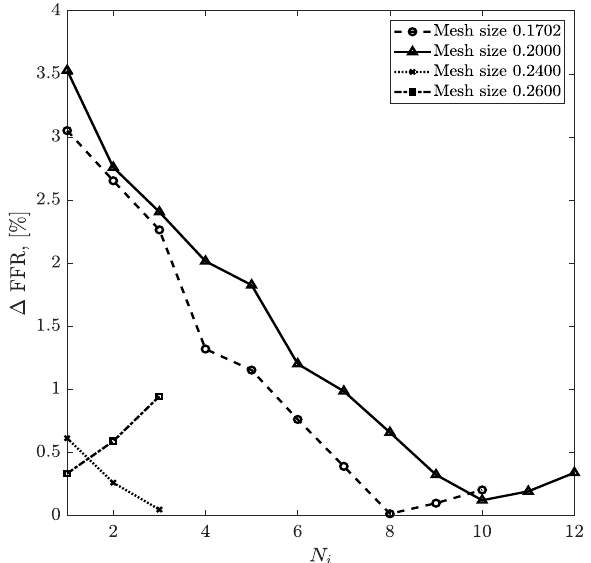
Figure 12. Relative differences between calculated and experimental FFR in each round of iterations for CT209 [19].